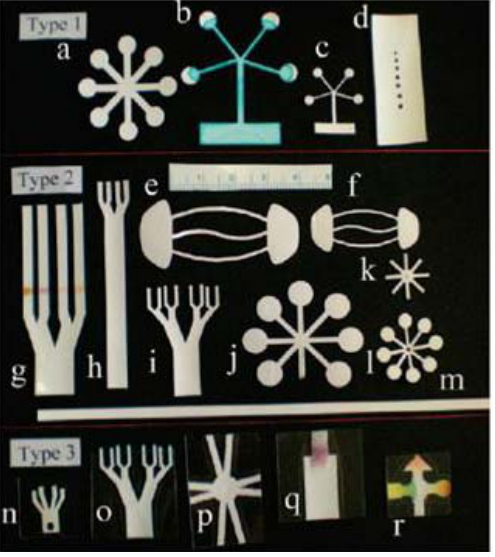
Figure 3. Three types of devices that have been cut into a variety of two dimensional shapes. Type 1 is fabricated by shaping polyester-backed nitrocellulose membrane, Type 2 is formed by capping the nitrocellulose membrane or filter paper with a polyester cover tape and then shaping it and Type 3 is fabricated by first shaping the nitrocellulose membrane or filter paper and then capping both sides with a polyester cover tape and then creating an inlet for the fluid. (Reprinted with permission from Fenton et al. ACS